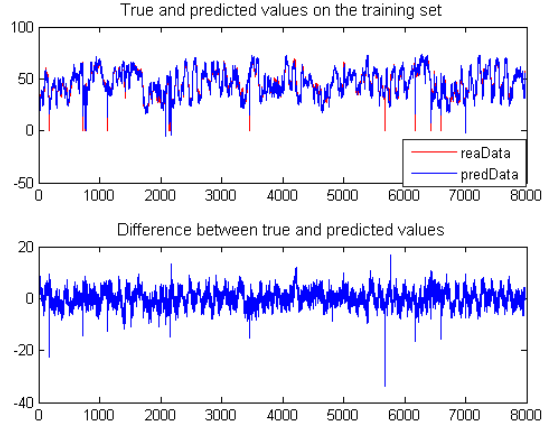
Figure 5. Prediction of ESN model on training set.